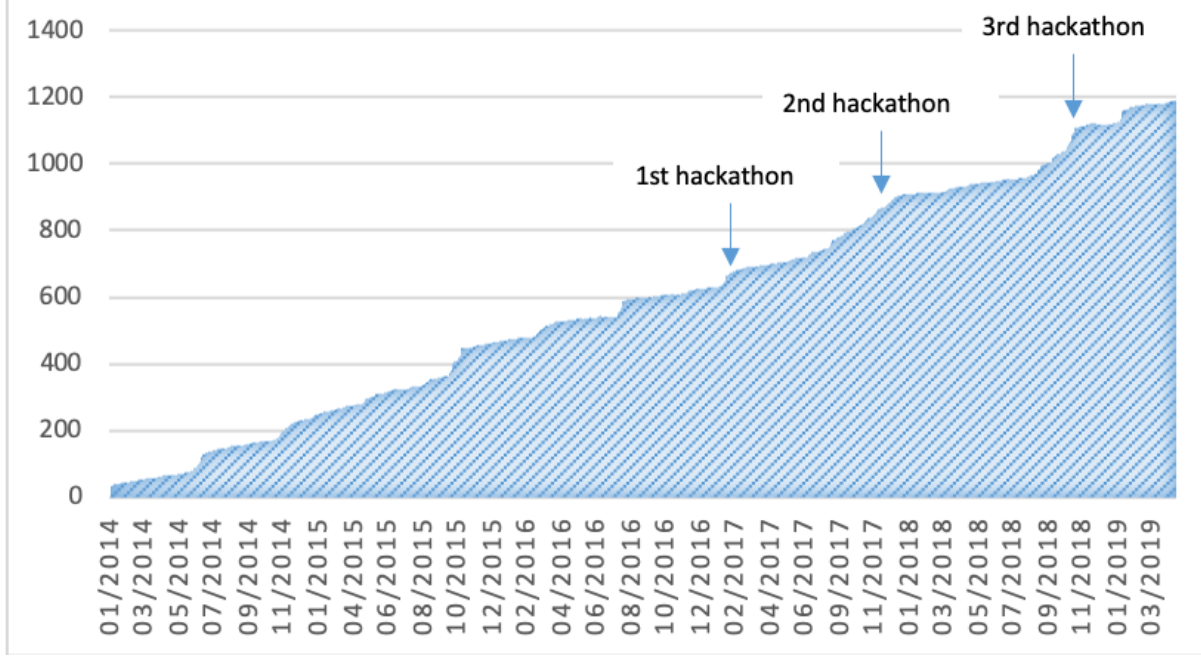
Figure 2. Total number of members of the Meetup group Hacking Health Berlin from January 2014 to March 2019. The three hackathons are marked with arrows